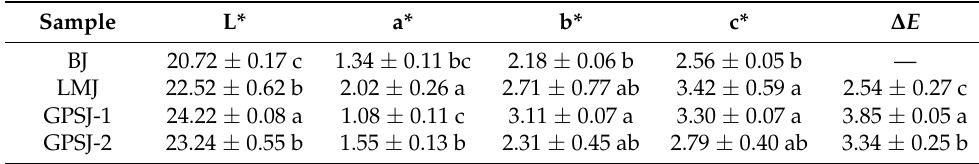
Table 1. Color parameters of blueberry